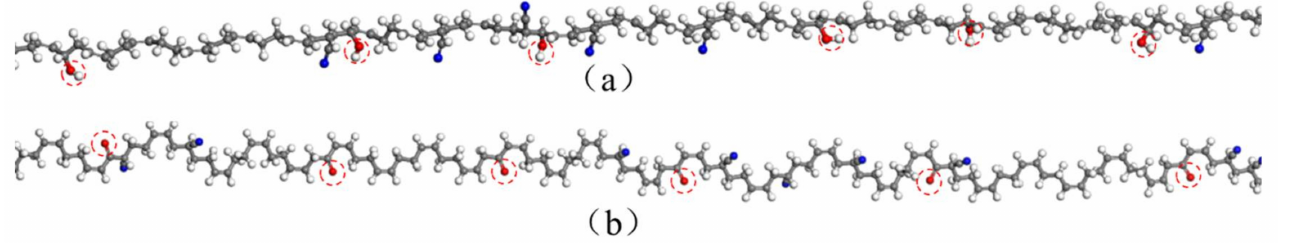
Figure 2. The aged nitrile rubber molecular chain: ( a ) modified by the hydroxyl groups; ( b ) modified by the carbonyl